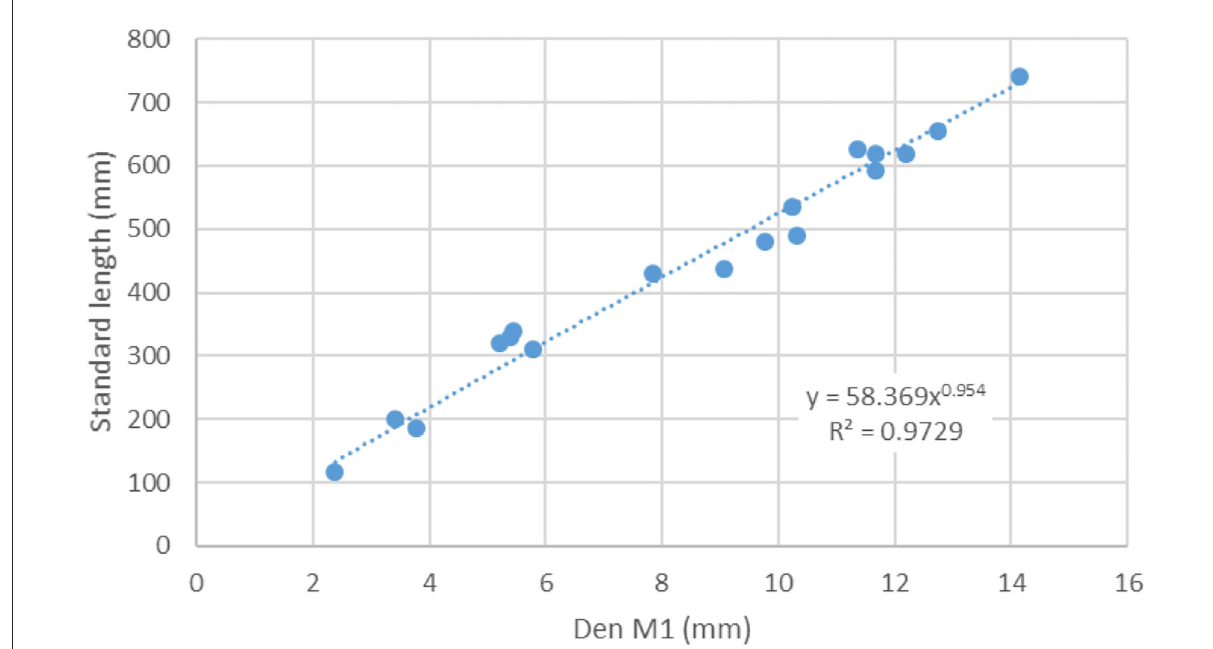
FIGURE5 Lateolabrax maculatus graph modeling the regression formulas of Den M1 vs. SL.